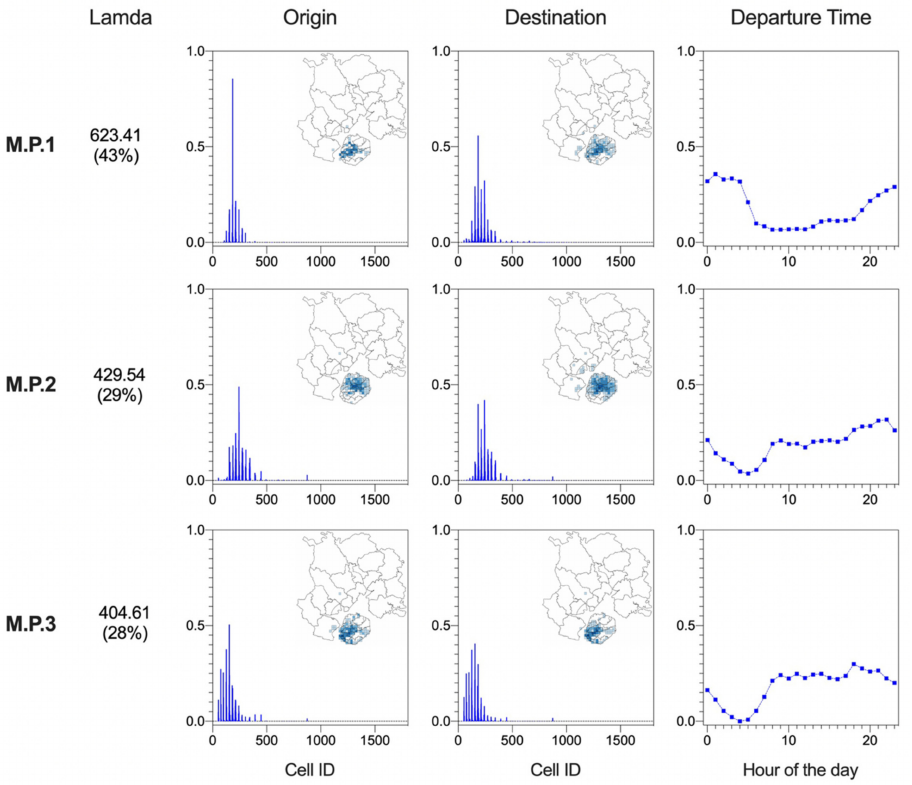
Figure 15. Meta-patterns of taxi mobilities at weekends.